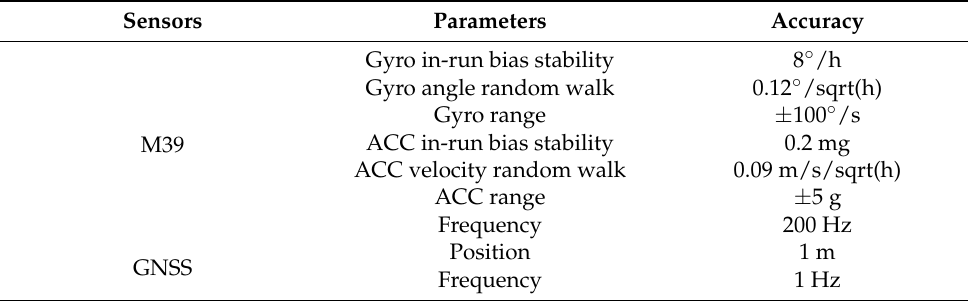
Figure 5. The equipment installation diagram. Table 1. Instruments and